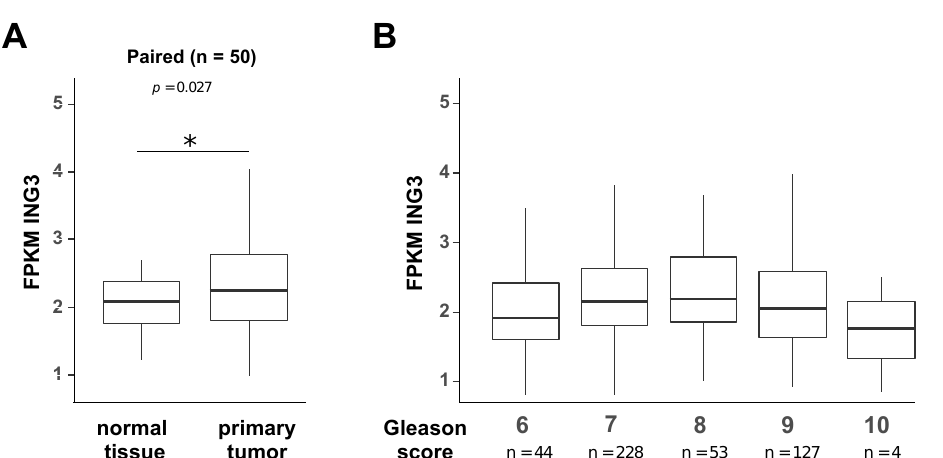
Figure 7. ING3 mRNA expression in PCa. TCGA database was analysed for full-length ING3 mRNA (NM-019071.3) levels in comparison ( A ) between primary tumour and normal tissues from the same patient and ( B ) among Gleason scores. Wilcoxon signed-rank test (paired for A and unpaired for ( B ) was performed to test the significance. Only significant comparisons are shown; p value < 0.05 (*).